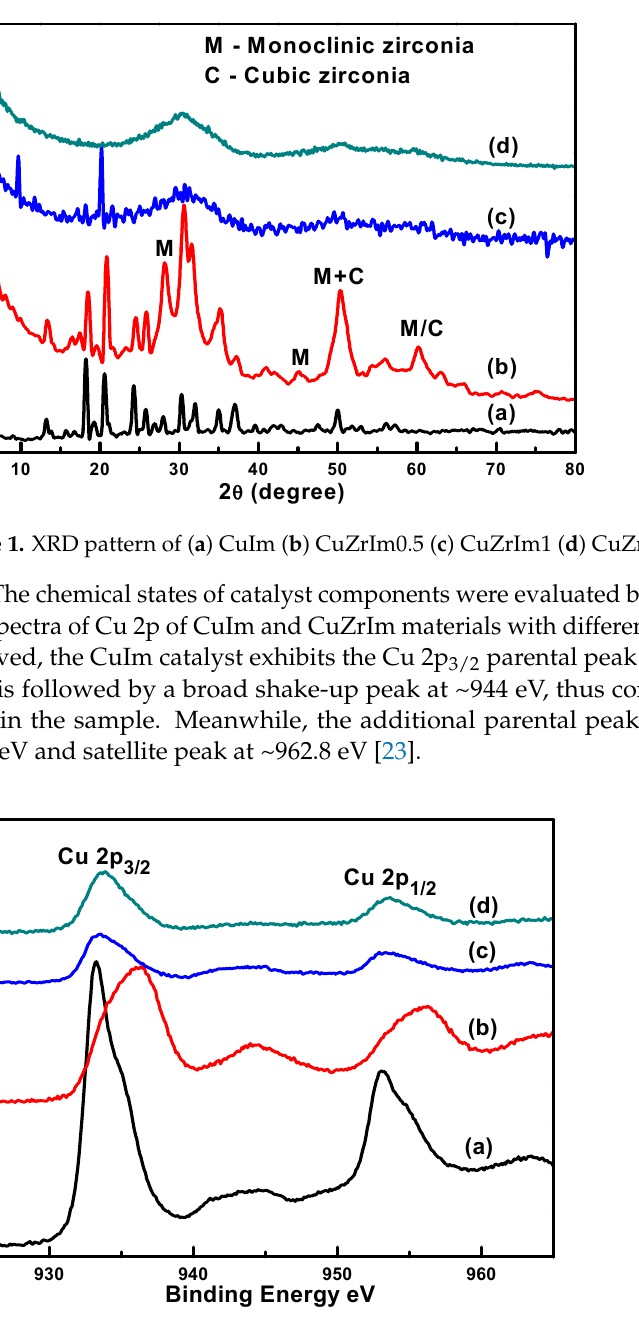
Figure 2. XPS Cu 2p spectra of ( a ) CuIm ( b ) CuZrIm0.5 ( c ) CuZrIm1 ( d ) CuZrIm1.5. Upon adding Zr into CuIm, each catalyst shows core electron peaks at binding ener- gies of ~934 eV and ~954 eV (or Cu 2p 3/2 and Cu 2p 1/2 parental peaks, respectively). Each core electron peak is associated with a satellite peak of binding energy gap 9 eV at 943 eV and 962 eV [19]. The association of shake-up peaks with the parental peaks shows that Cu is found mainly in the form of Cu 2+ in the CuZrIm catalyst. The Zr 3d XPS spectra are shown in Figure 3. Two apparent XPS peaks which corre- spond to Zr 3d 5/2 , as well as Zr 3d 3/2 , are detected at 182.2 eV and 184.8 eV, respectively. The occurrence of two XPS peaks with an energy gap of 2.6 eV indicated the presence of Zr 4+ as ZrO 2 [24–27]. Additionally, N 1s spectra of the synthesized catalyst can be seen in Figure 4. The binding energies of N 1s spectra in all samples at around between 399–401 eV, which shows the presence of N bond angle with metal atoms. 175 180 185 190 Binding Energy eV Zr 3d 5/2 Figure 3 . XPS Zr 3d spectra of ( a ) CuZrIm0.5 ( b ) CuZrIm1 ( c ) CuZrIm1.5 .